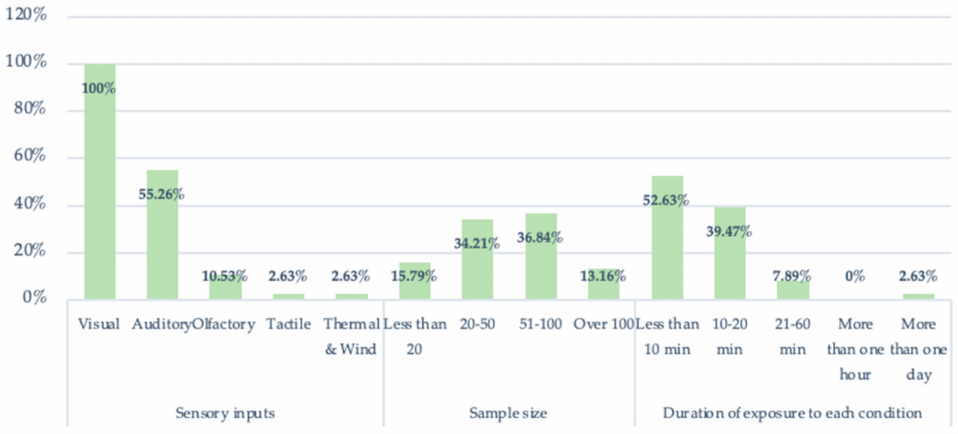
Figure 4. Distribution of the reviewed studies employing virtual natural environment based on sensory inputs, sample size, and duration of exposure to each